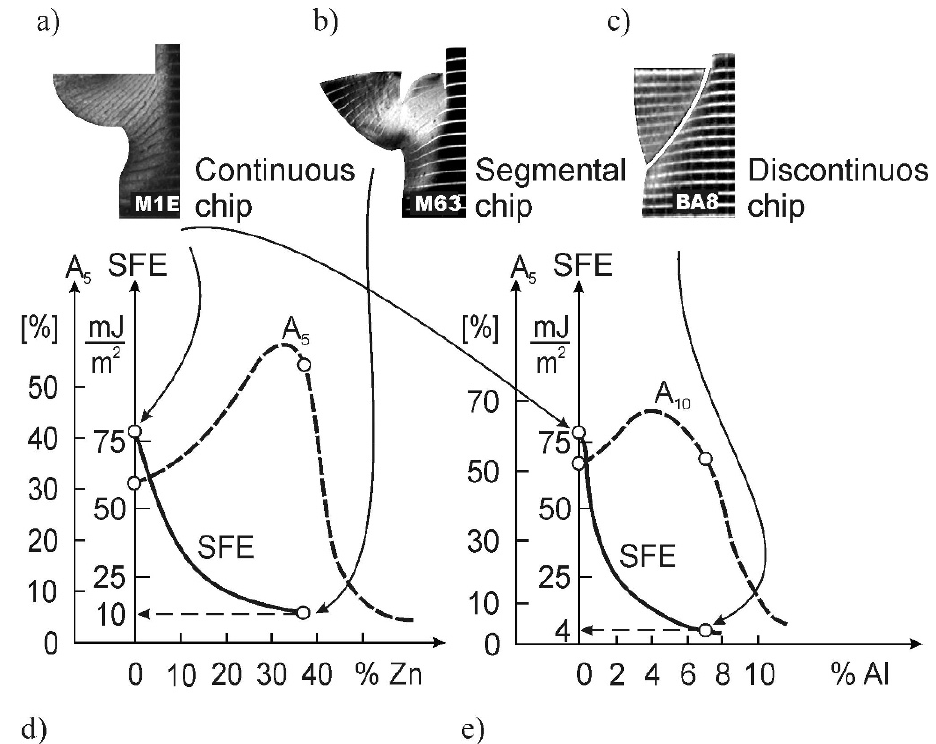
Figure 12. Influence of stacking fault energy on the type of chip (according to Dzidowski,